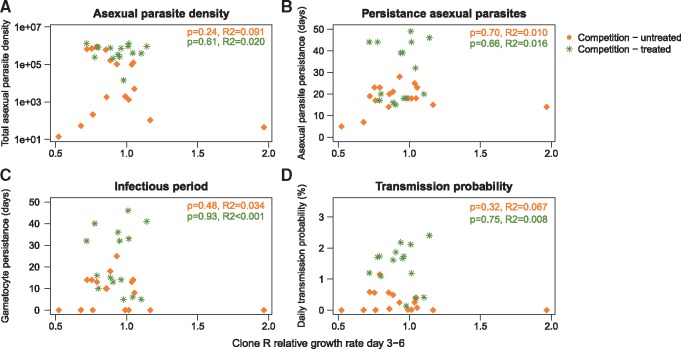
 Relationship between initial growth rates and fitness. Association between initial relative growth rate of clone R (in competition) compared to growth rate of clone S (days 3–6 post-infection) with four clone R fitness parameters: A) Total asexual parasite density, B) asexual parasite persistence, C) infectious period and D) transmission probability. Each symbol represents a single mouse, orange diamonds are untreated infections, green asterisks are drug treated (days 6–9 post-infection) infections. Level of significance from linear regression of the slope and associated R-squared values are given for both untreated (top line) and drug treated (bottom line) infections